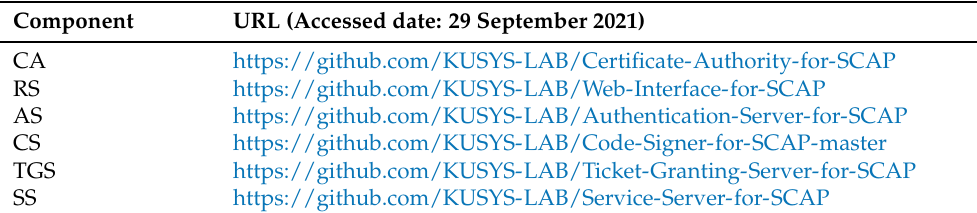
Table 1. Repositories for SCAP.